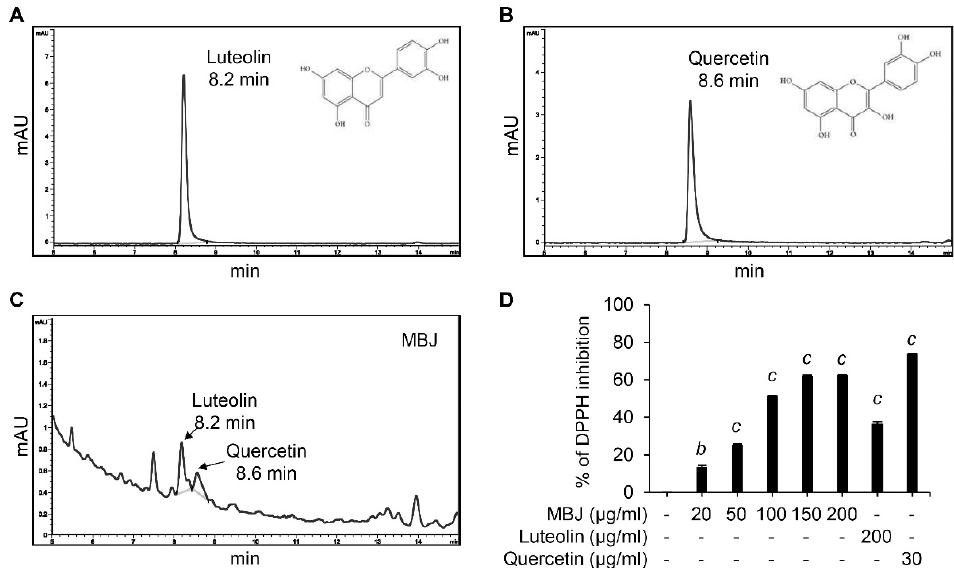
Figure 6. HPLC and DPPH assays. HPLC analysis data of ( A ) luteolin, ( B ) quercetin, and ( C ) MBJ. The chemical structures of luteolin and quercetin are illustrated in the top right corner. ( D ) The antioxidant effect of MBJ was analyzed using DPPH assays. Luteolin (200 µg/mL) and quercetin (30 µg/mL) were used as positive controls. The data are shown as means ± SEM. b p < 0.01 and c p < 0.001 vs. the non-treated control group.